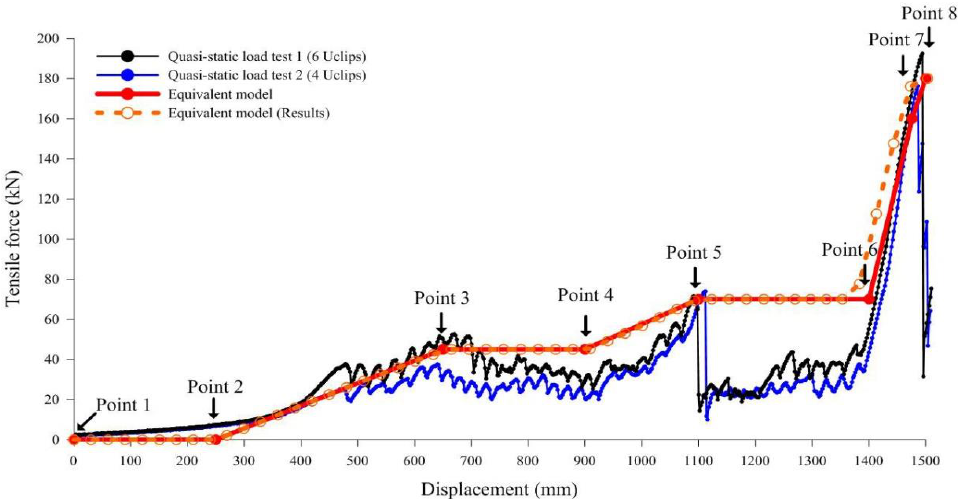
Figure 9. Representation of the equivalent model derived from quasi-static load tests and numerical analysis results using the model.